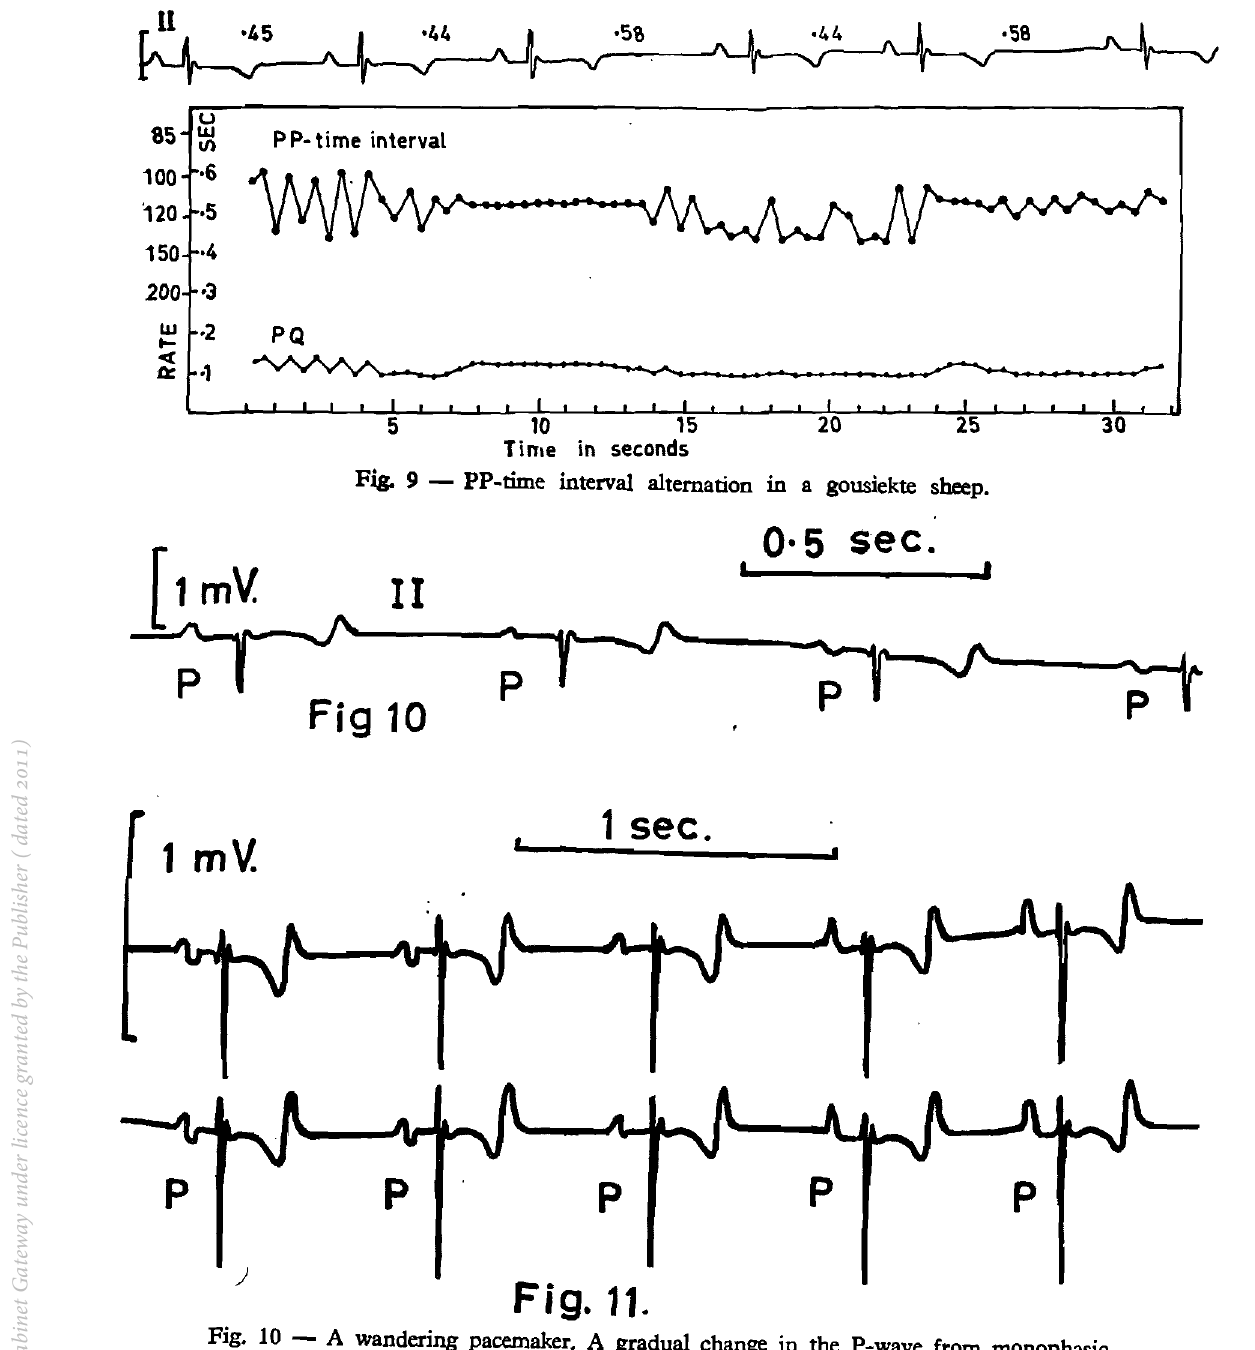
A wandering pacemaker. A gradual change in the P-wave from monophasic positive to bipbasic (+ / _ ). Fig. 11 - A wandering pacemaker. A sudden change in the P-wave from biphasic (+ / -) to monophasic positive. .